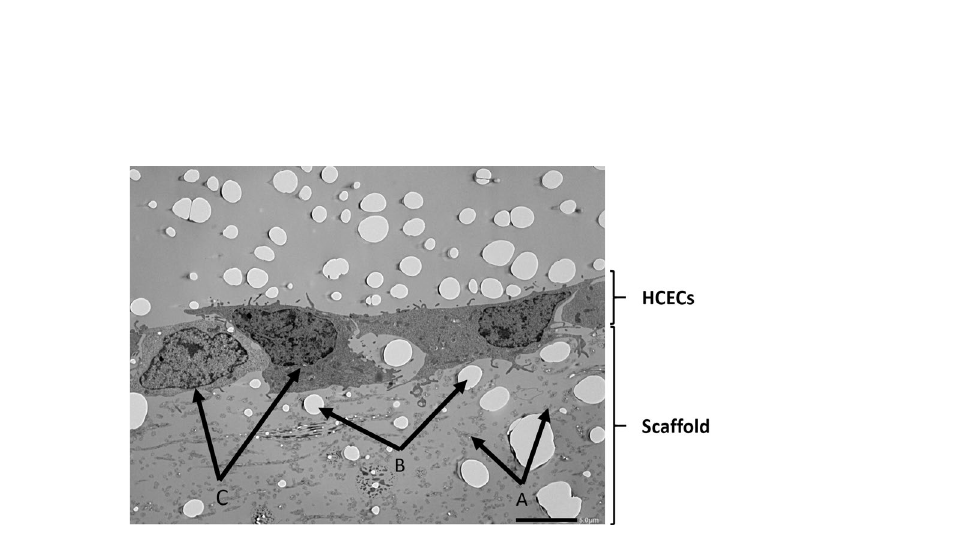
Figure 6. TEM image for the PCL-COL scaffold. ( A ) PCL-COL fibers ( B ) Artefacts from sample preparation ( C ) cell nucleus. Due to the low magnification single PCL-COL nanofibers are hardly visible. Scale bar: 5